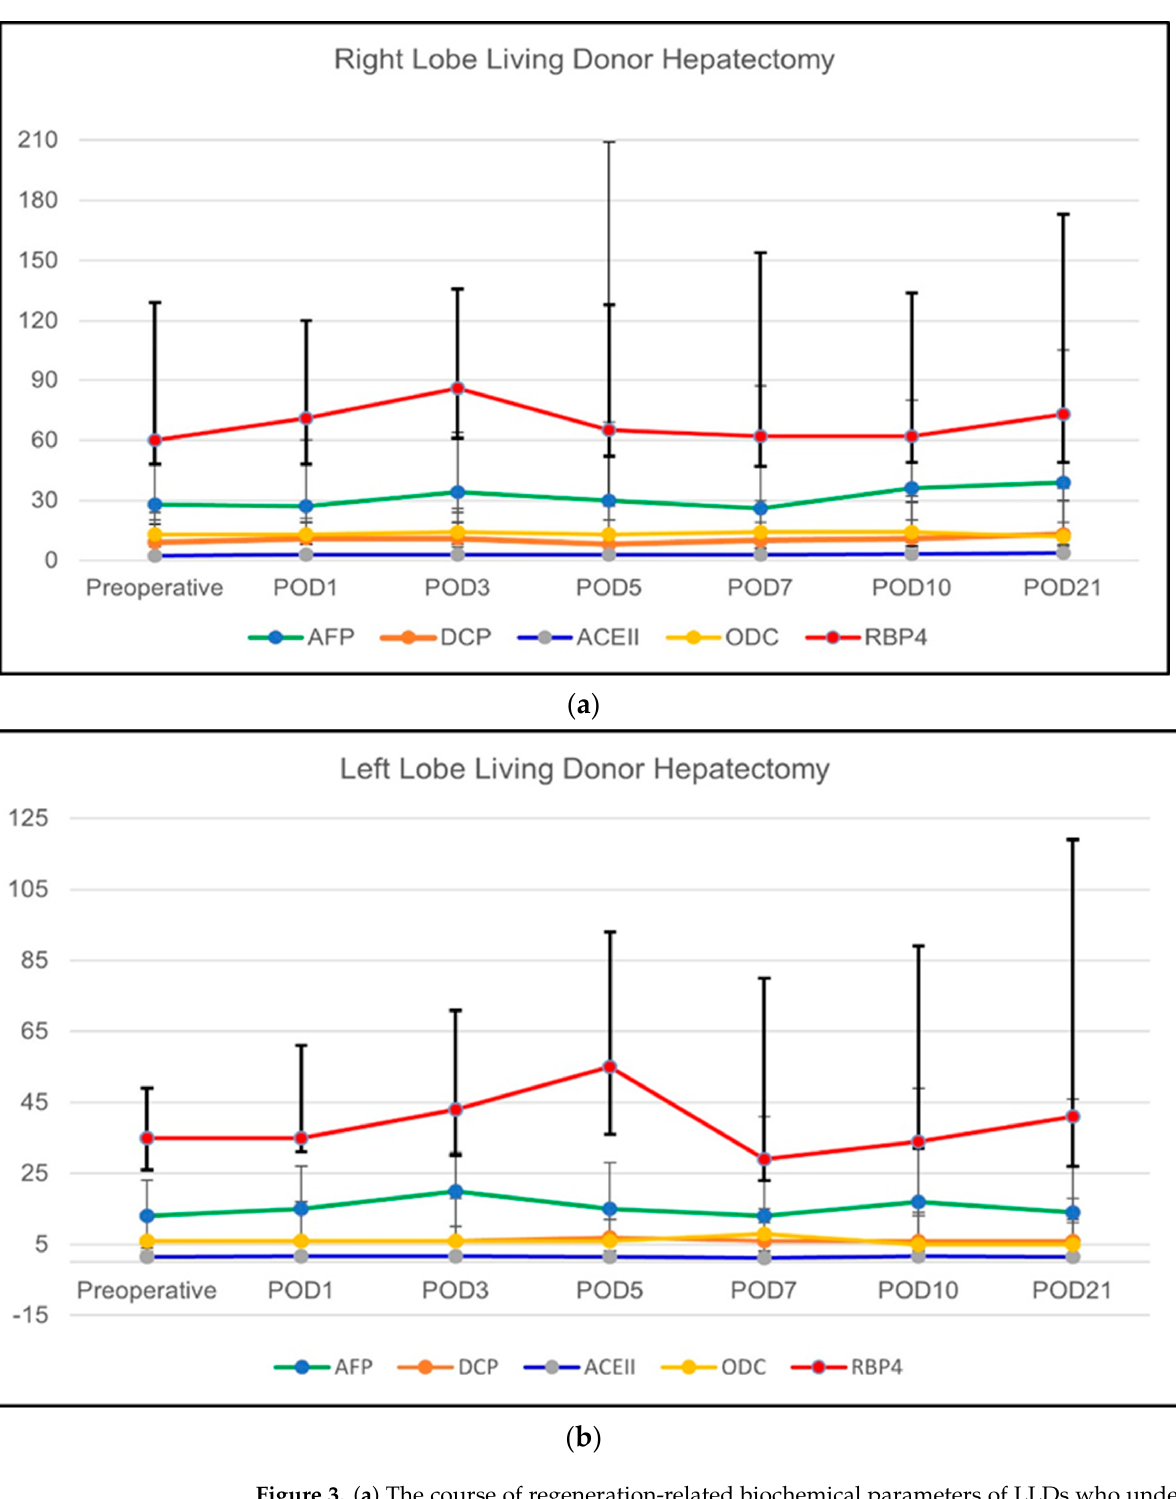
Figure 3. ( a ) The course of regeneration-related biochemical parameters of LLDs who underwent right-lobe LDH. ( b ) The course of regeneration-related biochemical parameters of LLDs who under- went left (including left lateral segment)-lobe